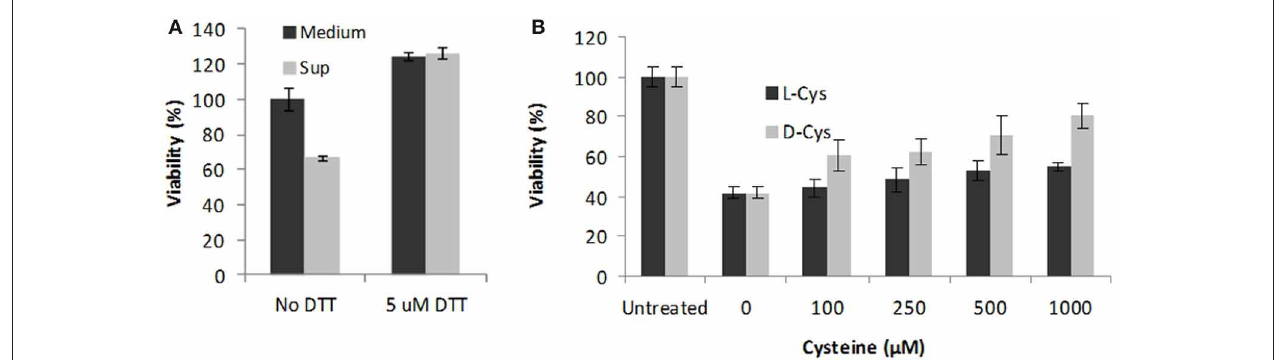
FIGURE 4 | Antioxidant treatment of Sups protects HSAECs. The dSterne Sups grown in complete DMEM/F12 were incubated with 5mM DTT for 30 min (A) or indicated concentrations of cysteine for 1h (B) . HSAECs were exposed to the treated Sups for 2h and the viability of